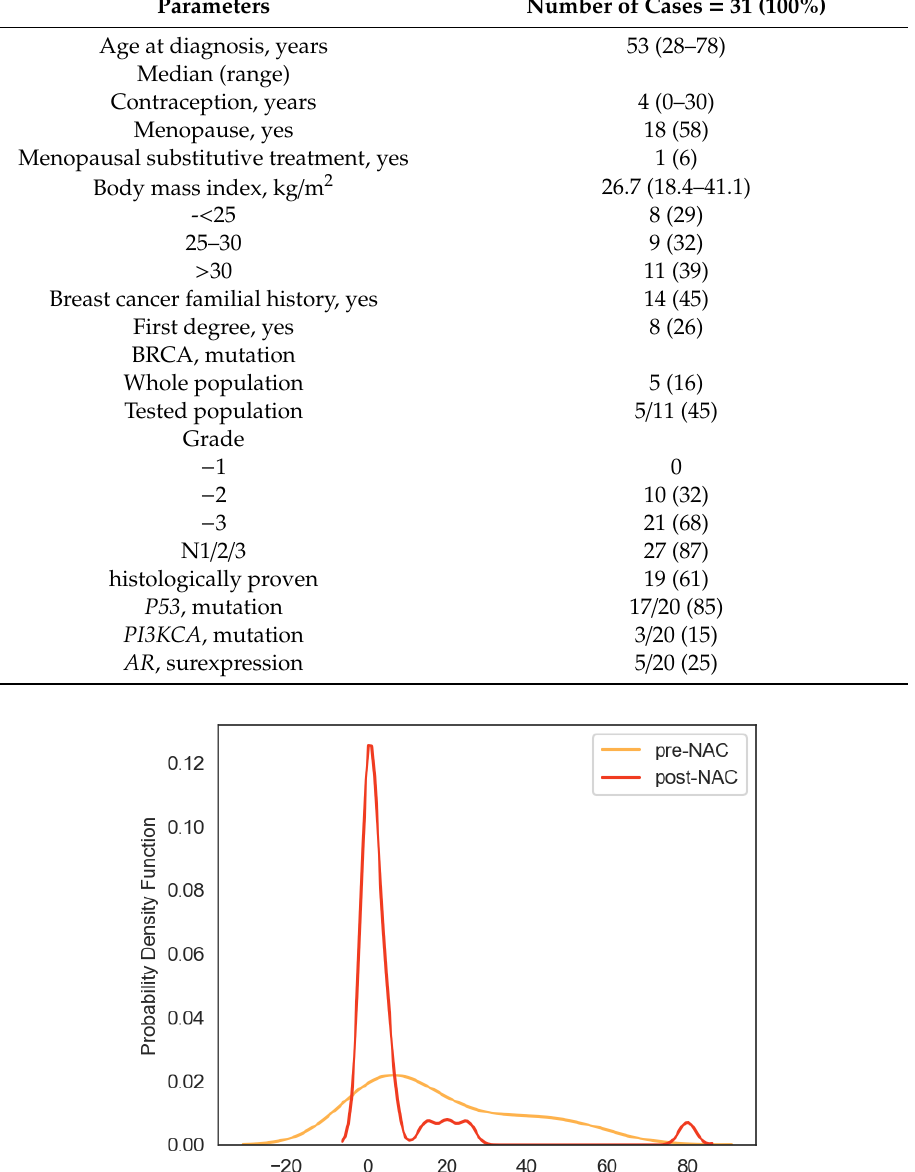
Table 1. Patients characteristics and tumor features.